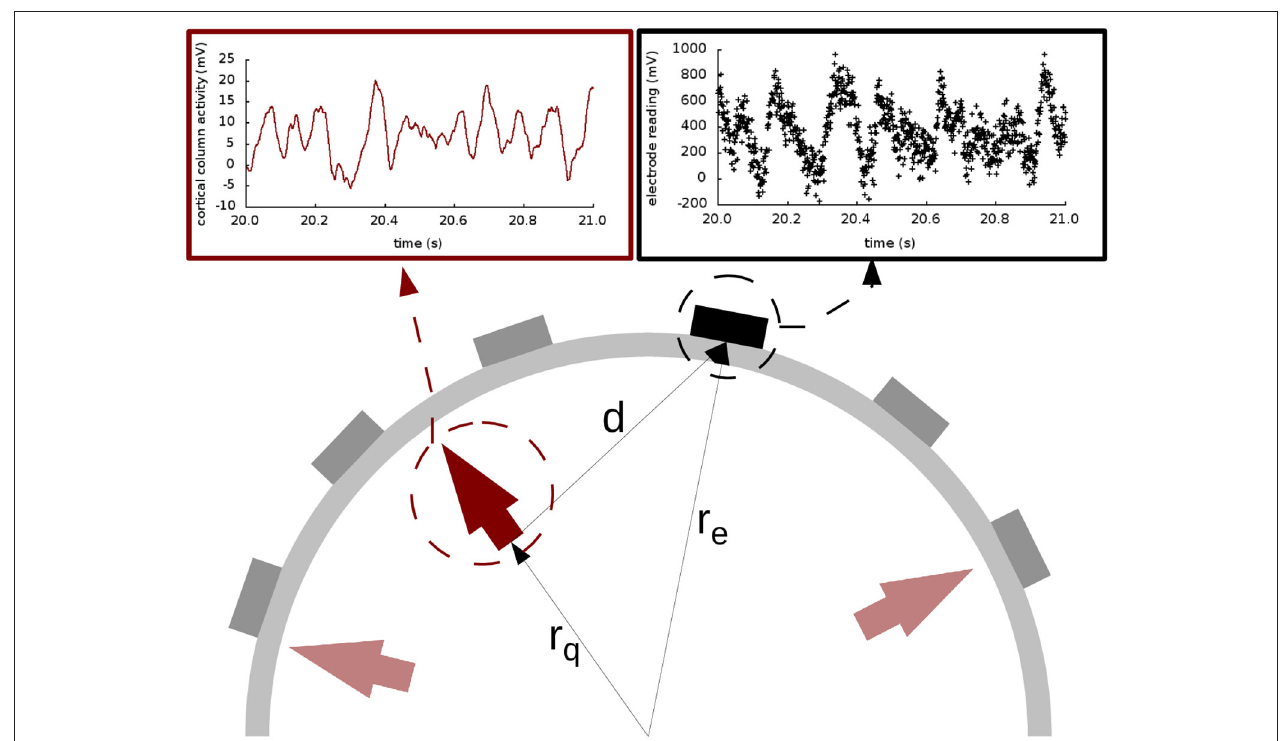
FIGURE 1 | Extracranial data generation and illustration of Ary’s model of the head. The light and dark red arrows indicate dipole sources, and the electrodes are shown as gray and black rectangles. The elements in the cartoon illustrate how all the signals produced by the cortical columns (represented with the solid red line in the top left panel) are transformed into an electrode reading (shown in black dots in the top right panel) through the lead field matrix. In this drawing, as in Equations (5–9), r q is the distance from the origin to the cortical column under consideration; r e is the distance from the origin to the electrode; and d is the distance from the cortical column to the electrode. The placement of the arrows here is for illustration purposes only; in our study, the cortical columns are placed on the surface of the brain, close to the skull.